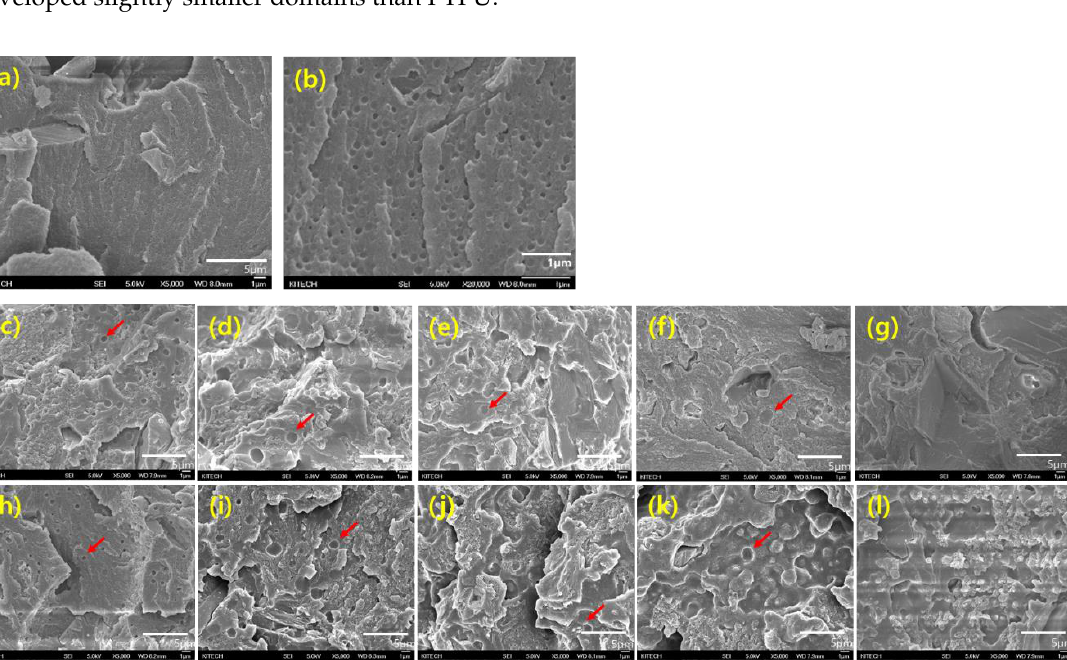
11 of 16 Figure 10. Fracture surfaces of IWP specimens: ( a ) control; ( b ) 5 wt % PTPU; ( c ) 10 wt % PTPU; ( d ) 15